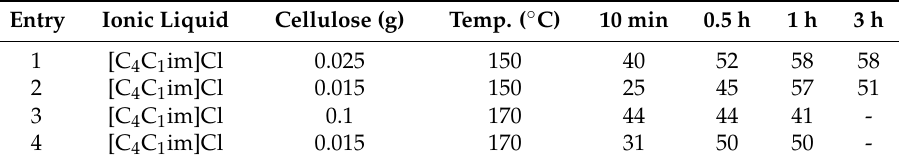
Table 3. Effect of cellulose concentration on HMF yield (%) at elevated temperatures. Entry Ionic Liquid Cellulose